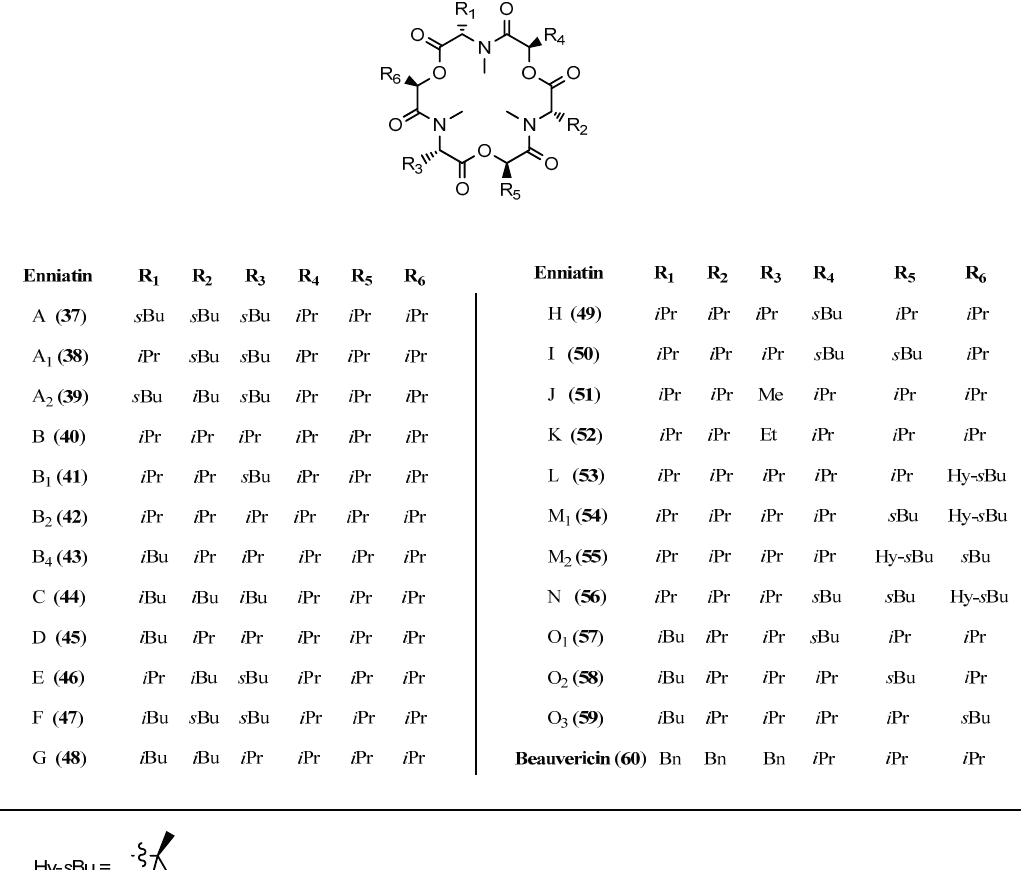
Figure 7. Structures of enniatins 37 – 59 and beauvericin ( 60